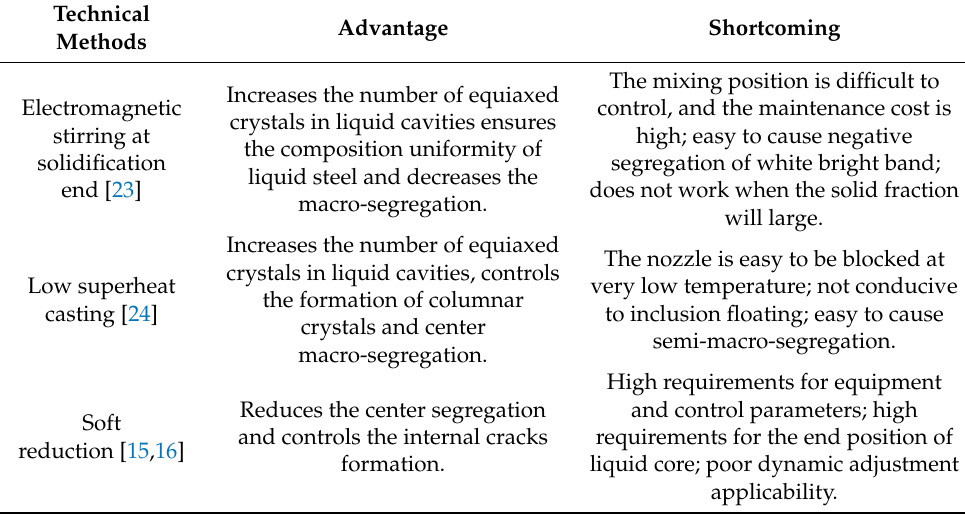
Table 2. The different technologies to overcome the center segregation in continuous casting